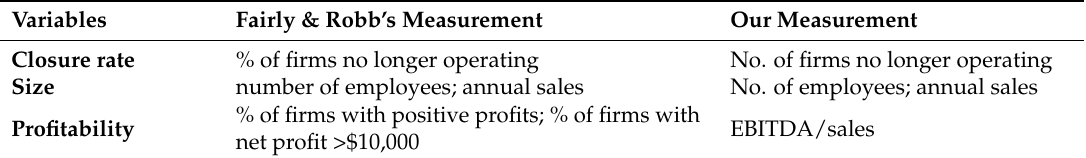
Table 3. Business